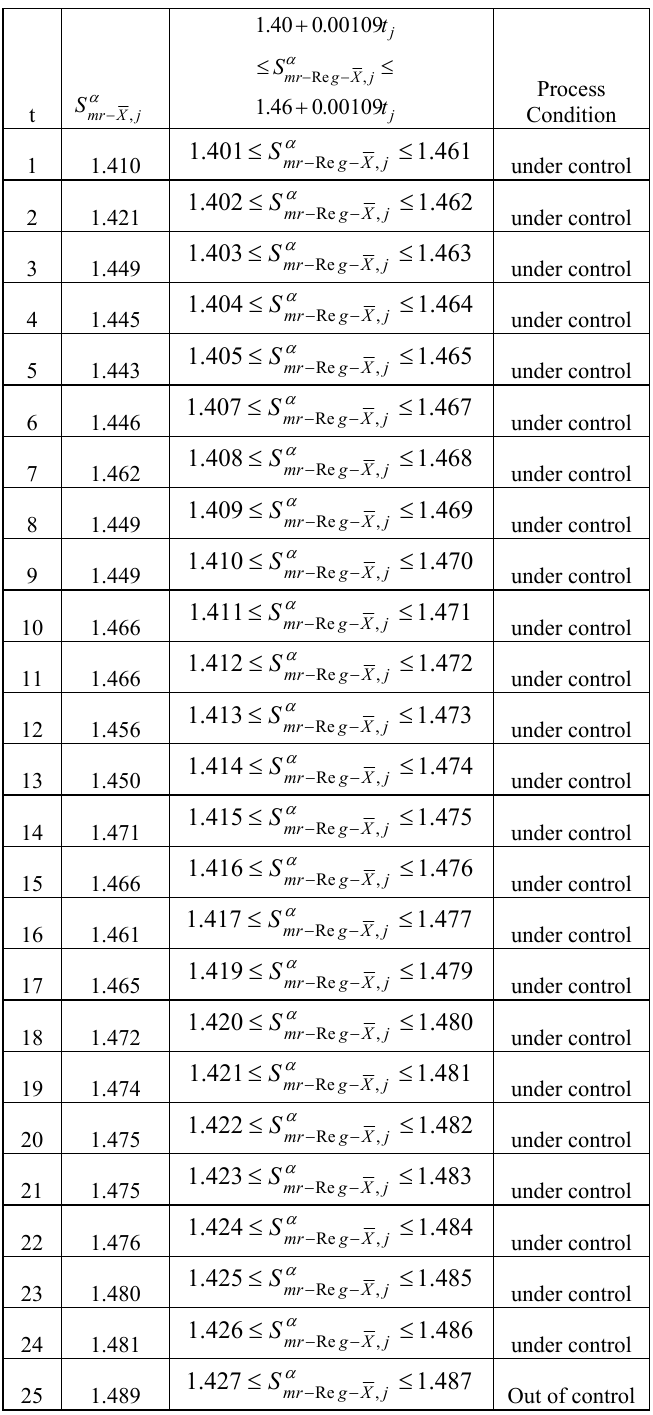
Table 5. Control limits using the α -level fuzzy midrange for the α -cut fuzzy X chart based on